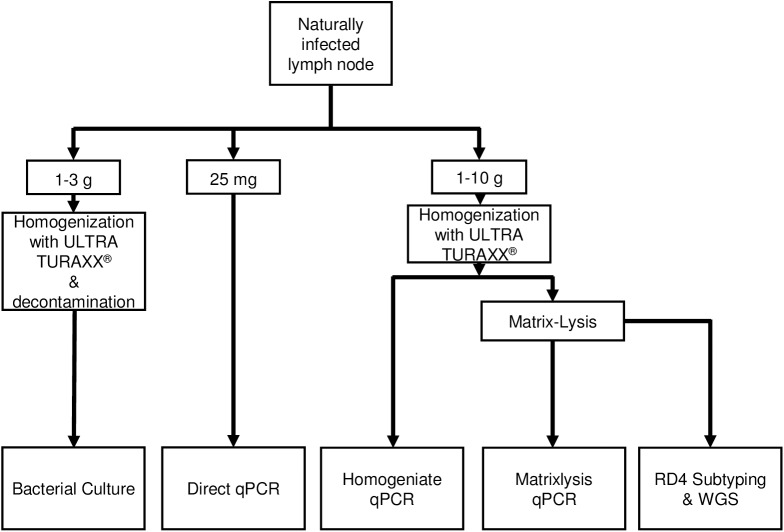
Workflow of samples.